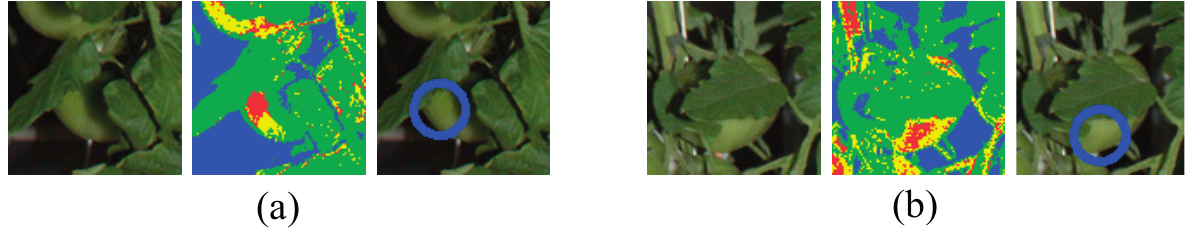
Figure 11. Examples of fruit detection under difficult conditions. The original images are to the left. The middle images show the results of pixel-based segmentation. The images to the right show the results of fruit